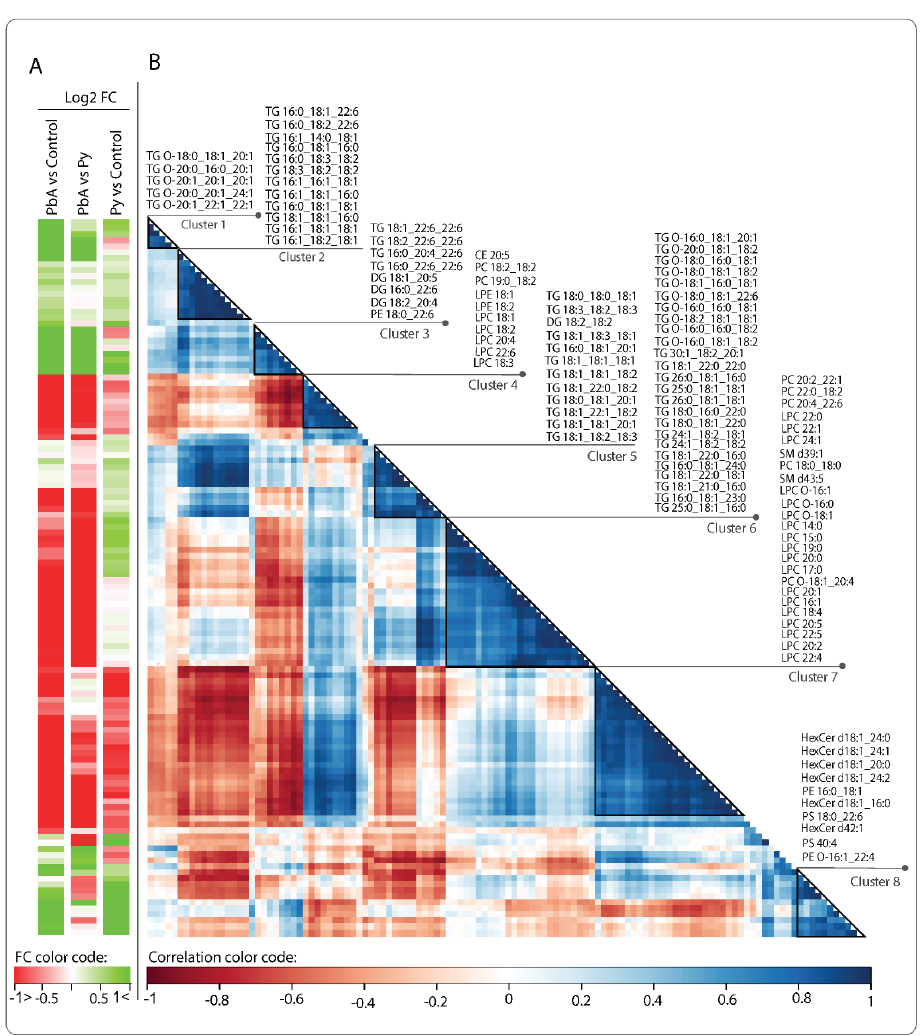
Figure 5. Correlation plot of the 121 retained lipids across all the samples. ( A ) Fold changes (FC) of lipid amounts in the three categories of comparisons. Green denotes an increase and red a decrease. ( B ) Hierarchical clustering of the lipid – lipid correlation matrix, where the pairwise Pearson corre- lation was conducted across all samples in the three categories. Rows and columns correspond to the 121 retained lipid species. Dark blue triangles indicate clusters (1 – 8) of strongly positively cor- related lipids. Cluster numbers and corresponding lipid names are shown on the right.